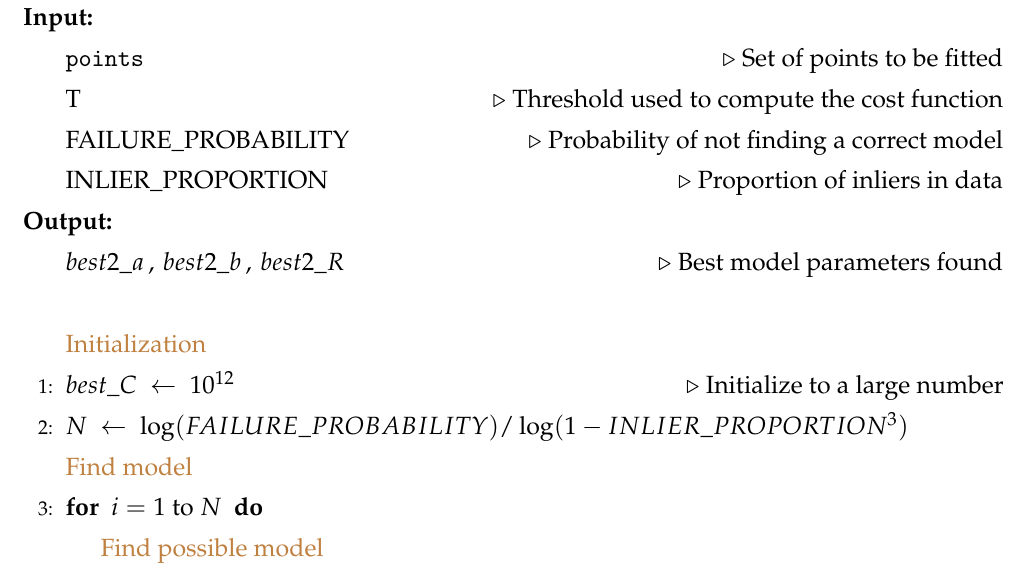
Algorithm 1 Circular model-fitting with outlier